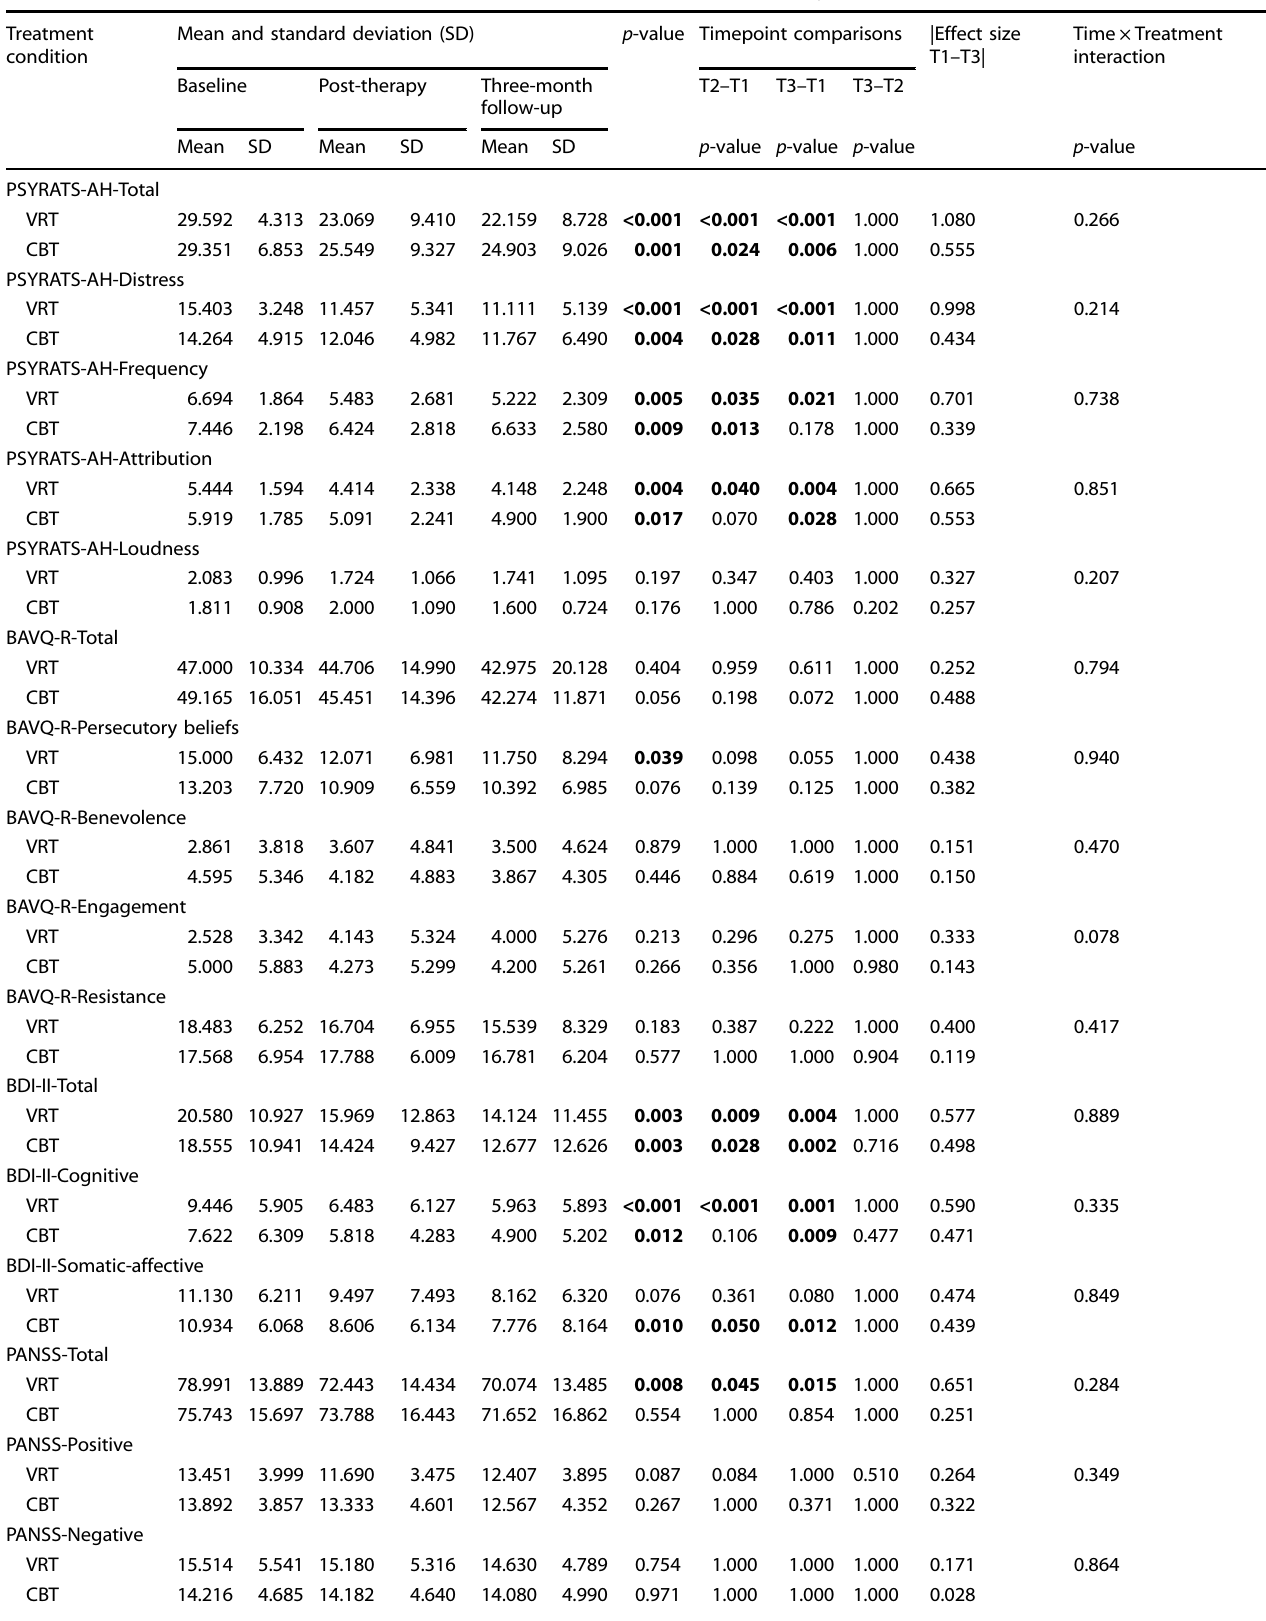
Table 2. Outcomes at baseline, post-treatment, and 3-month follow-up for short-term ef fi cacy comparison. Treatment